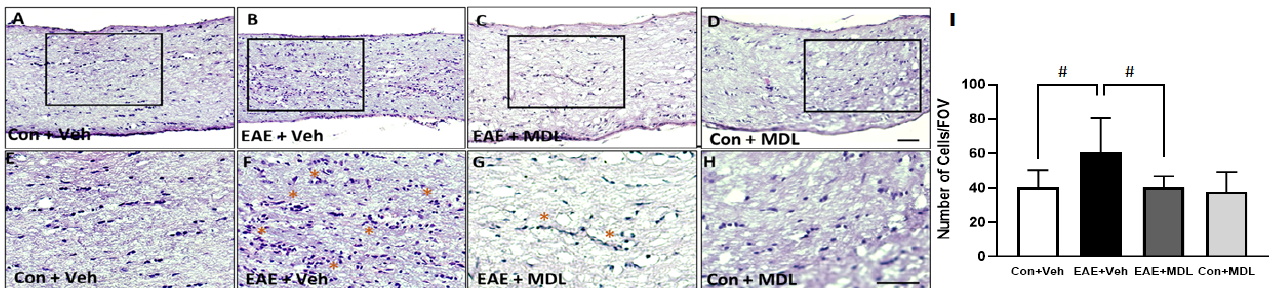
Figure 6. EAE-induced cellular infiltration in the optic nerve is reduced by SMOX inhibition. ( A – D ) Representative images of H&E stained optic nerve sections from control and EAE mice treated with vehicle or MDL 72527. Increased infiltration is evident in vehicle EAE sections, while SMOX inhibition markedly reduced this effect. ( E – H ) High magnification images of boxed regions demonstrate EAE-induced cellular infiltration. Clusters of infiltrated cells are shown with asterisks. ( I ) Histogram representing the quantification of infiltrated cells in optic nerve sections using ImageJ. Data are presented as mean ± SD. # ( p < 0.05). Representative images are presented. n = 6–10 per group. Scale bar 50 μ m.